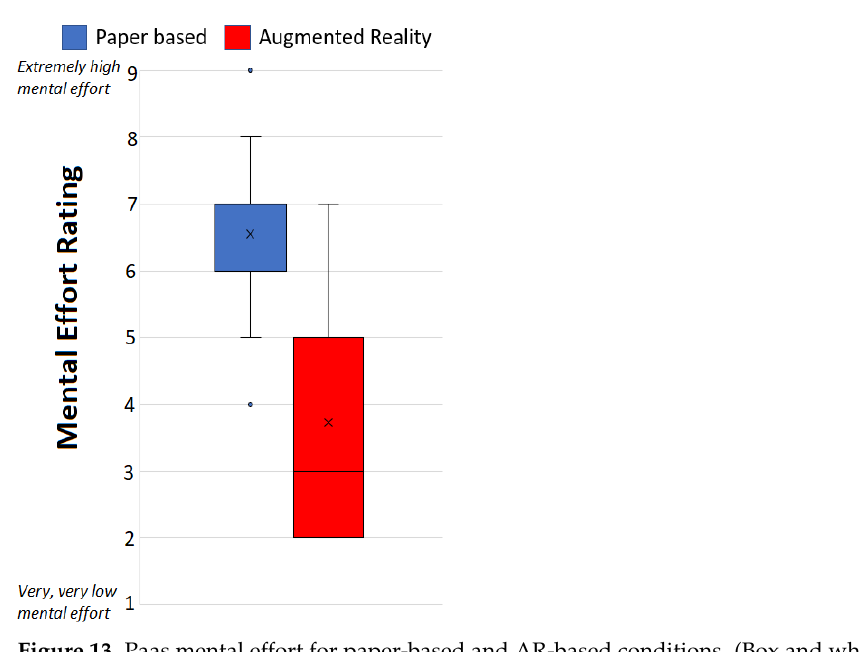
Figure 13. Paas mental effort for paper-based and AR-based conditions. (Box and whiskers